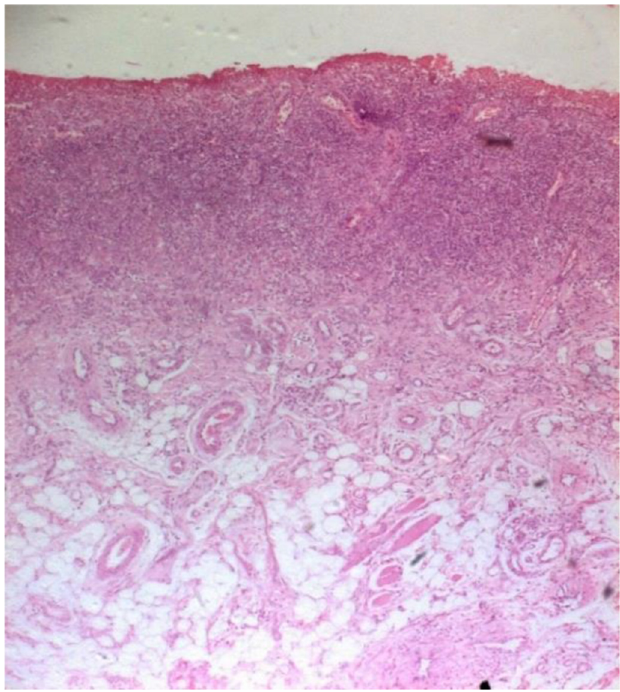
Fig. 2. HE * 40: Hyperplasic epithelioma, parakeratosis, liquefaction and degeneration of the basal layer. A band-like plasmocytes in fi ltrate in the dermal – epidermal interface.